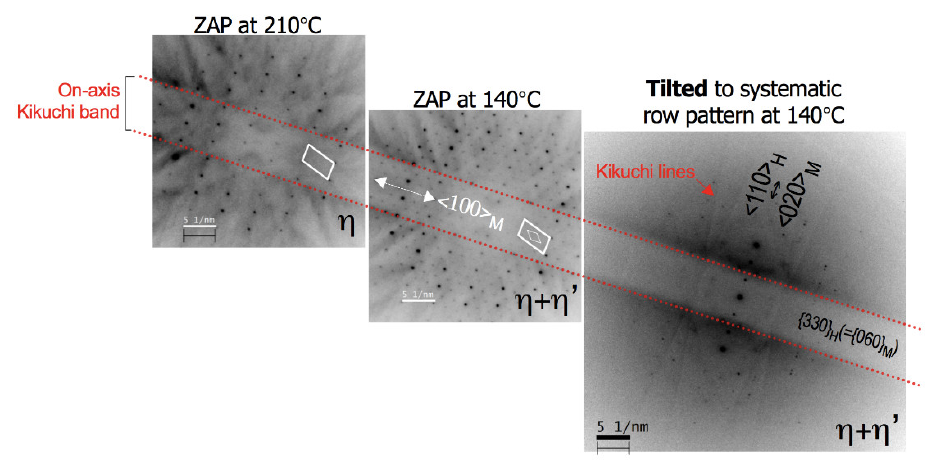
Figure 4. Series of SADPs in this study tilted to the on-axis {330} H (={060} M ) Kikuchi band.